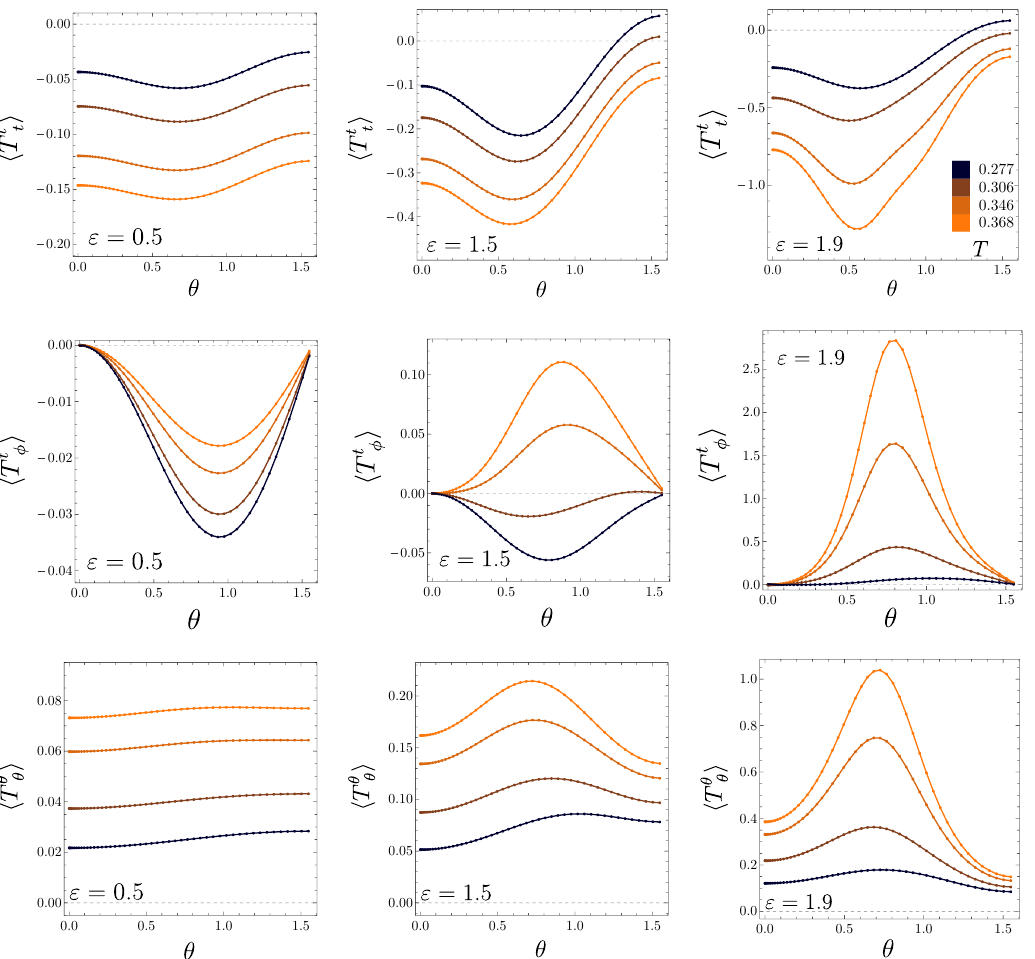
Figure 9 . Independent stress-energy tensor components of the dual to the large black holes against (cid:18) , for several values of the parameter " . Colouring codes black hole temperature with darker colours representing temperatures closer to T min ( "